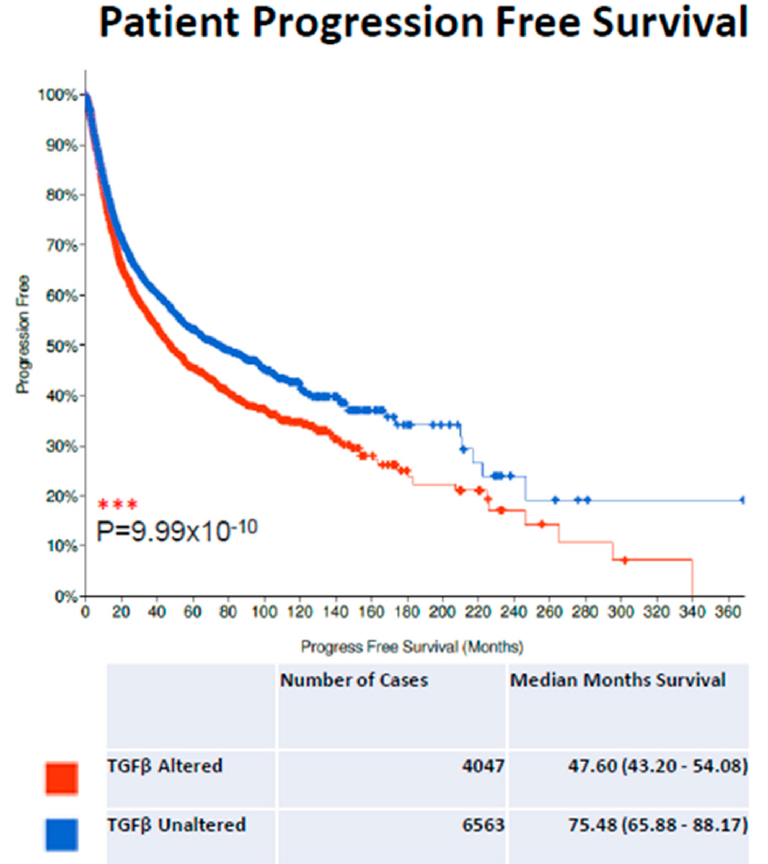
Figure 2. Database analysis of patients with TGF- β -altered/unaltered gene expression and survival. Kaplan–Meier curves for progression-free survival of the patients with alterations in TGF- β signaling in cancer samples (red curve) in comparison with patients with unaltered expression (blue curve). n = 10,610, *** p = 9.99 × 10 − 10 , log-rank test.